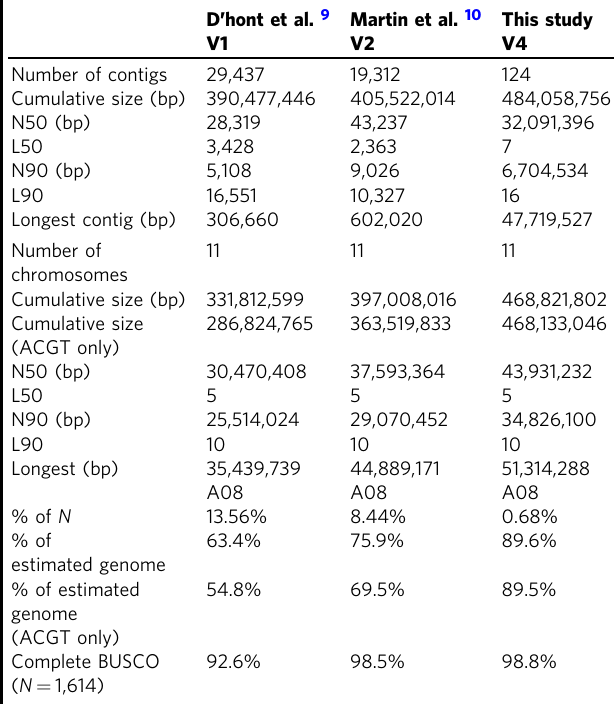
Table 1 Comparison of Musa acuminata (DH-Pahang) genome